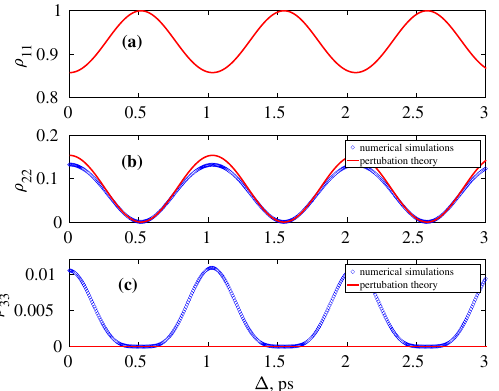
Figure 4. Dependence of the populations ρ 11 ( a ), ρ 22 ( b ), and ρ 33 ( c ) on the delay (cid:31) between two Gaussian THz pulses for the H 2 O molecule. Blue circles show the result of the numerical simulations, red solid line show the analytical results obtained from Eq. (19). Parameters: E 0 0.97 THz, all the relaxation times T ω 0 / 2 π = orks.com).